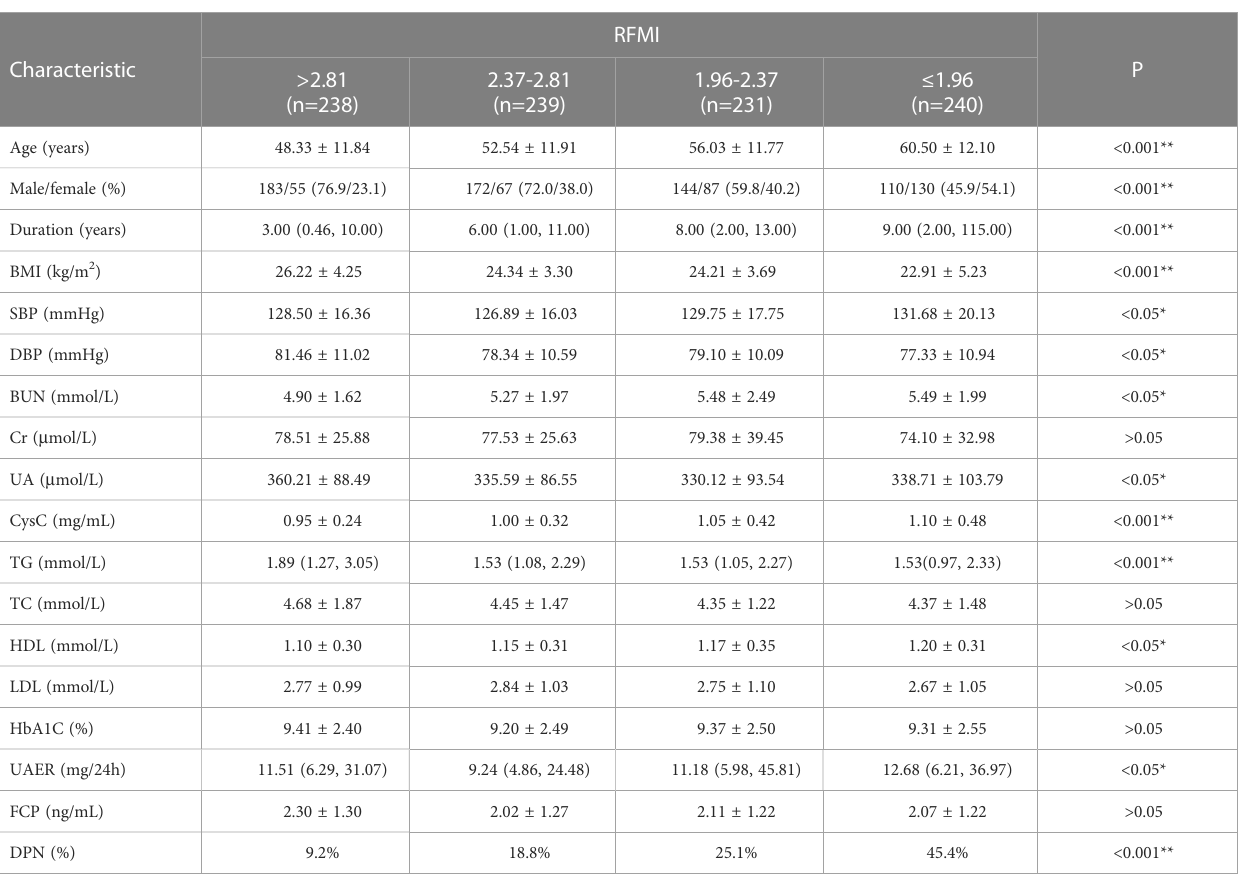
TABLE 2 Clinical characteristics of T2DM patients strati fi ed by RFMI categories.